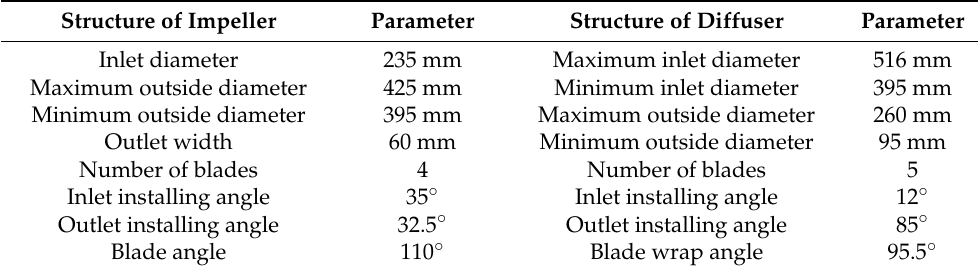
Table 2. Main design parameters of the